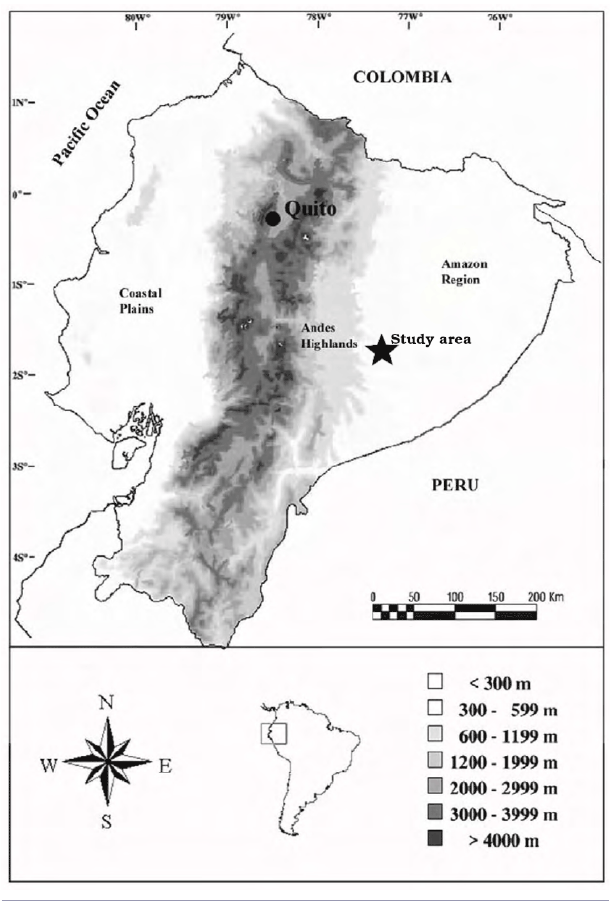
Fig. 1 . Location of Sarayaku in the eastern lowlands of Ecuador (adapted from Zapata-Ríos